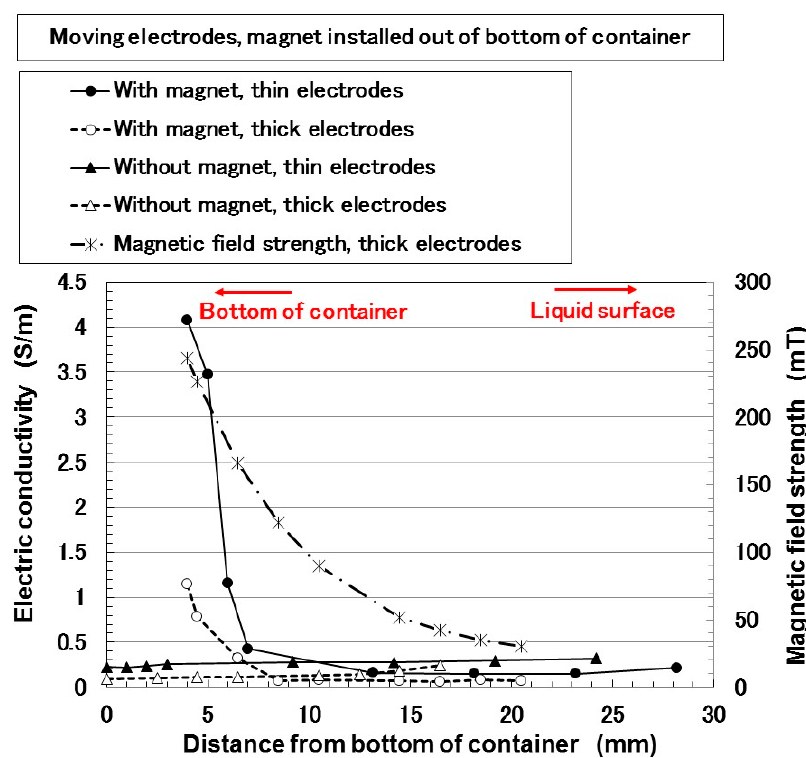
Figure 8. Comparison of electric conductivity with changes in the distance of the container between thin and thick electrodes for moving electrodes with installation of a magnet at the bottom of the outer wall of the container.